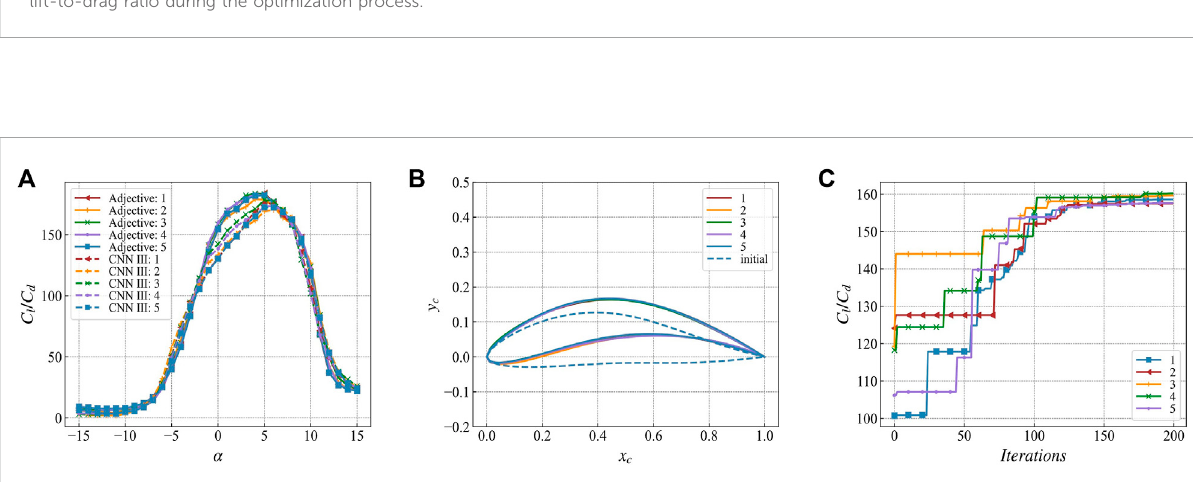
FIGURE 10 The optimization result of ion number M = 50 (A) The lift-drag ratio prediction of the fi ve optimization results by Adjective and CNN Ⅲ (B) The airfoil geometry of the fi ve optimization results and the initial airfoil optimized at one time (C) 5 times The change curve of the weighted value of the lift-to-drag ratio during the optimization process.